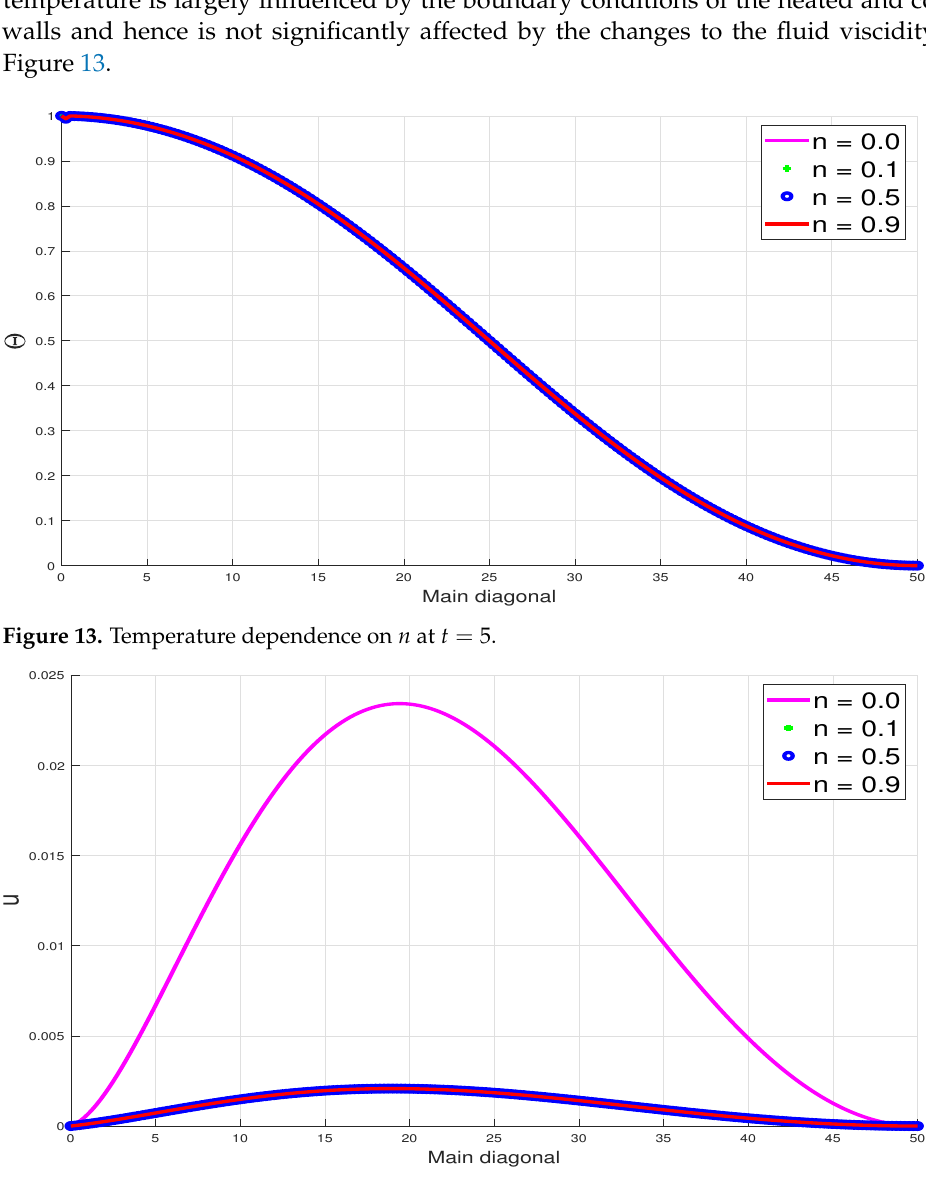
Figure 14. Axial velocity dependence on n at t =